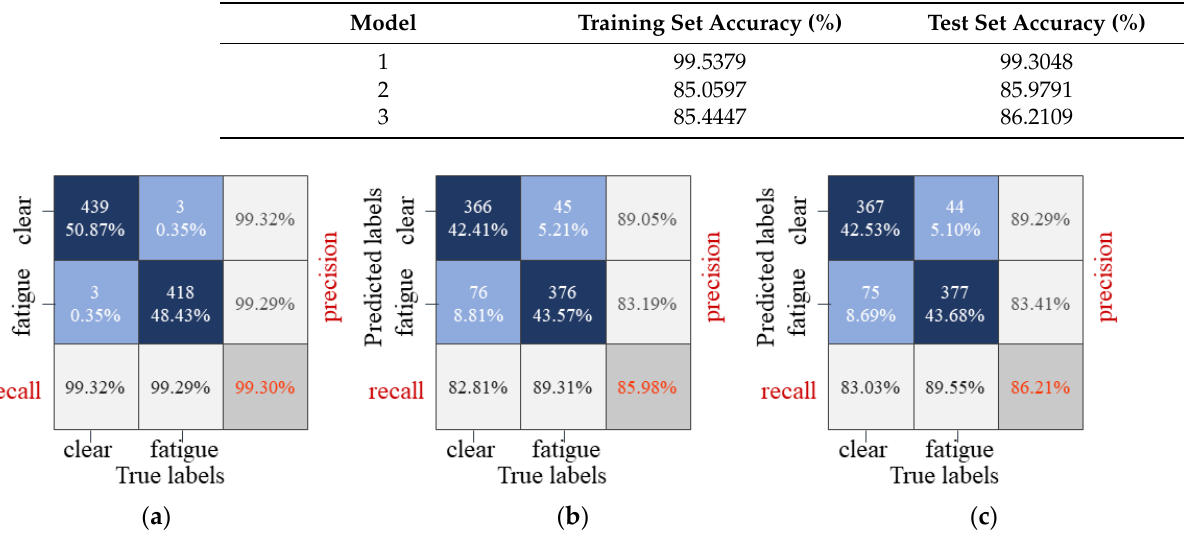
Figure 9. Confusion matrix diagram. ( a ) Classification result of model 1; ( b ) classification result of model 2; ( c ) classification